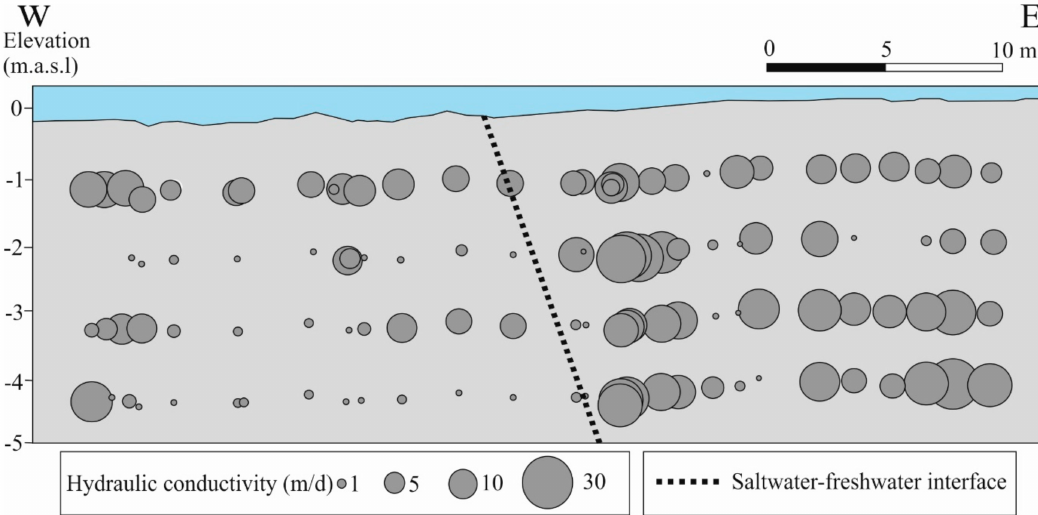
Figure 6. Hydraulic conductivity at the di ff erent depths measured, and location of the freshwater– saltwater transition in groundwater (vertical scale ×